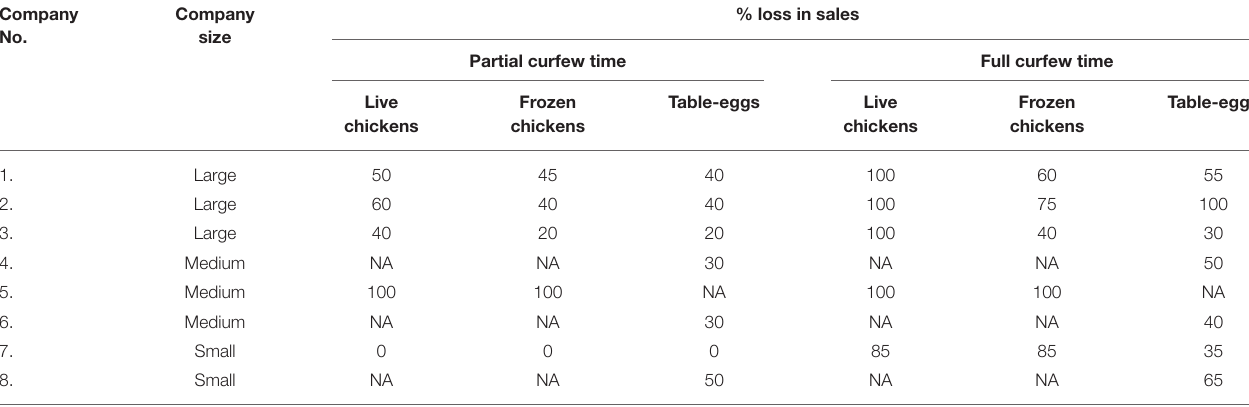
TABLE 5 | Sale size after the crisis in the eight poultry farms in Kuwait. Company no.